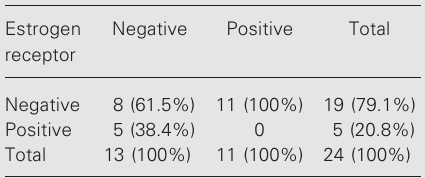
Table 1. Association between human papillomavi- rus (HPV) and estrogen receptor in the epithelium of cervical intraepithelial neoplasias and invasive cervical cancers.